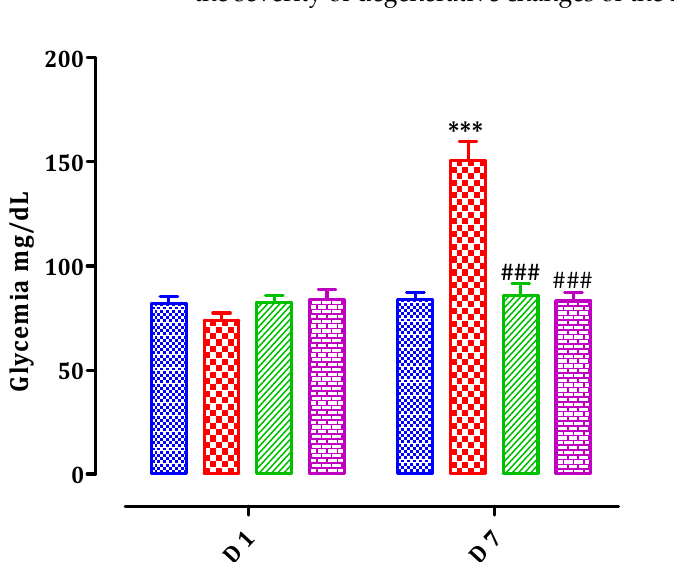
Figure 9. Effect of oral administration of EACe and ascorbic acid on blood glucose level before (D1) and after (D7) alloxan intraperitoneal injection in mice. Values represent the mean ± SEM, ( n = 7). *** p < 0.001 compared to the normal control group at the corresponding time. ### p < 0.001 compared to alloxan group at the corresponding time. (D1 = Day 1; D7 = Day 7).